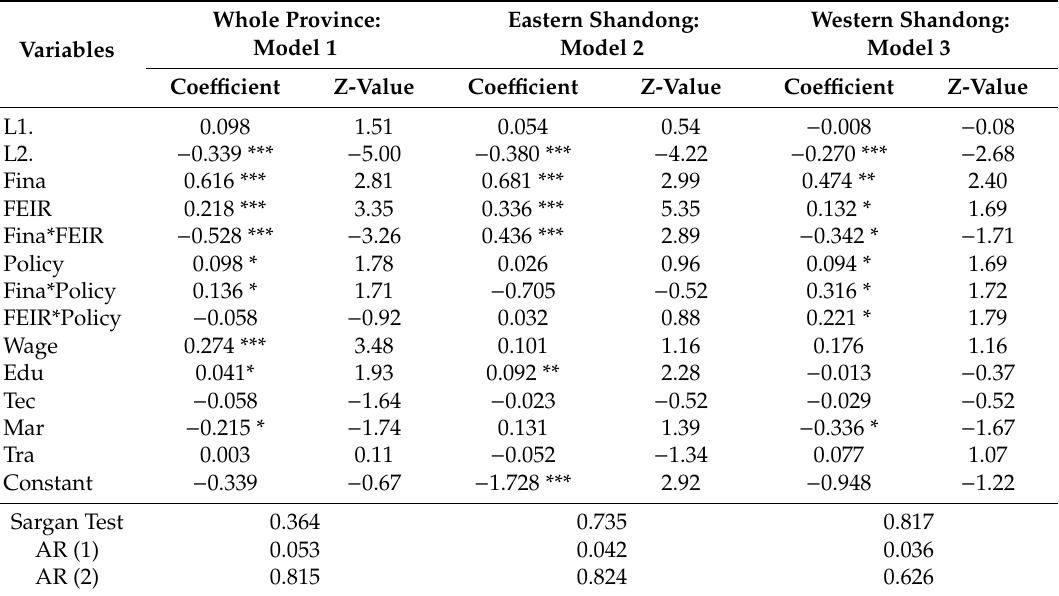
Table 4. Results of dynamic panel regression model